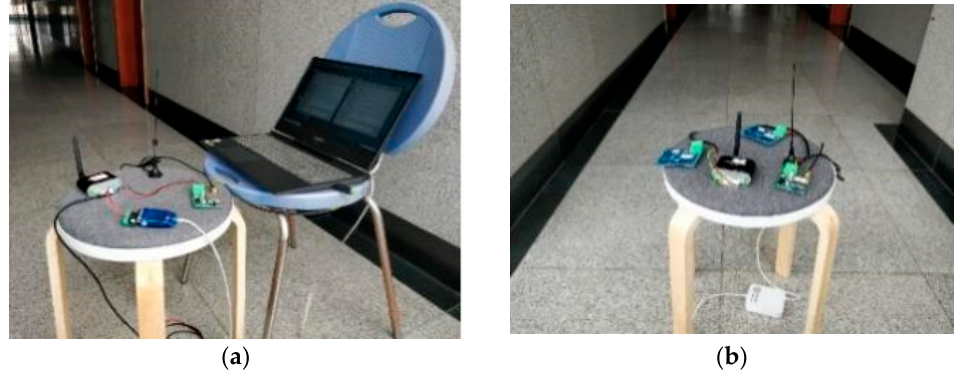
Figure 6. Equipment placement in line-of-sight scenario: ( a ) transmitter; ( b )